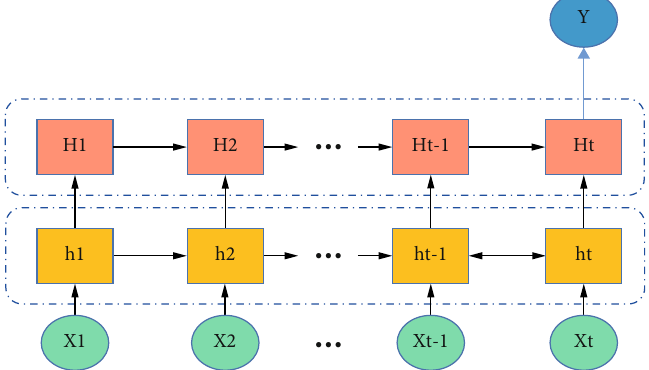
Figure 6: The structure of recurrent neural network